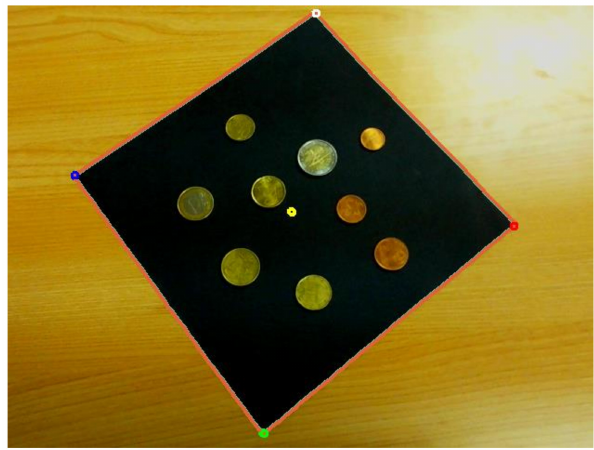
Figure 4. Cardboard